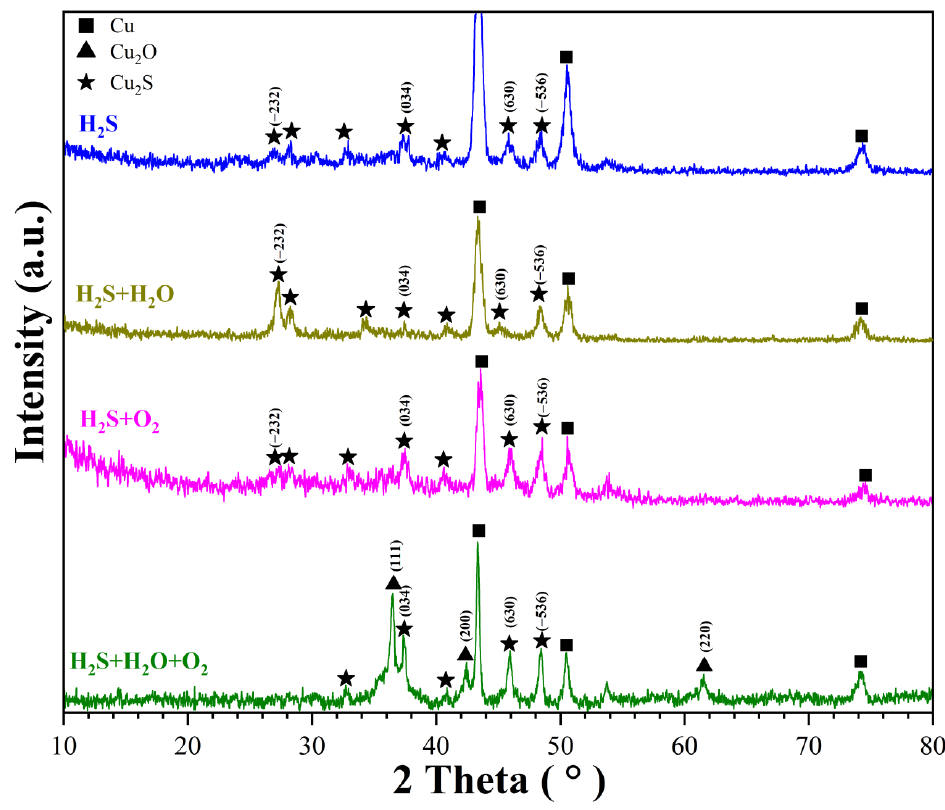
Figure 8. GIXRD patterns of corrosion products at different conditions.